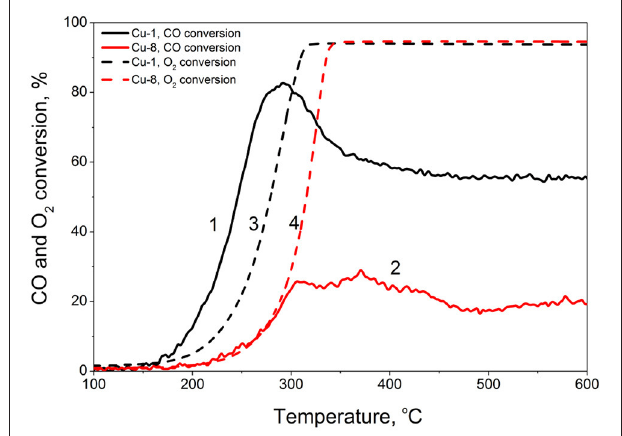
FIGURE 8 | PROX-CO reaction for Cu-1 (1,3) and Cu-8 (2,4) samples calcined at 600 ◦ C: CO conversion (1,2) and O 2 conversion